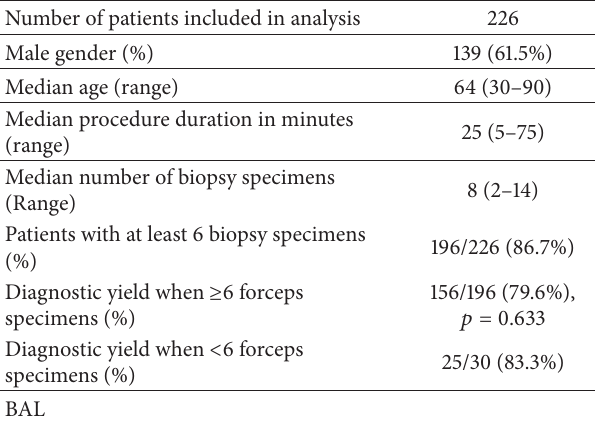
Table 1: Patient characteristics and procedure details. 𝑛 (%). Table 2: Positive diagnosis based on flexible bronchoscopy.